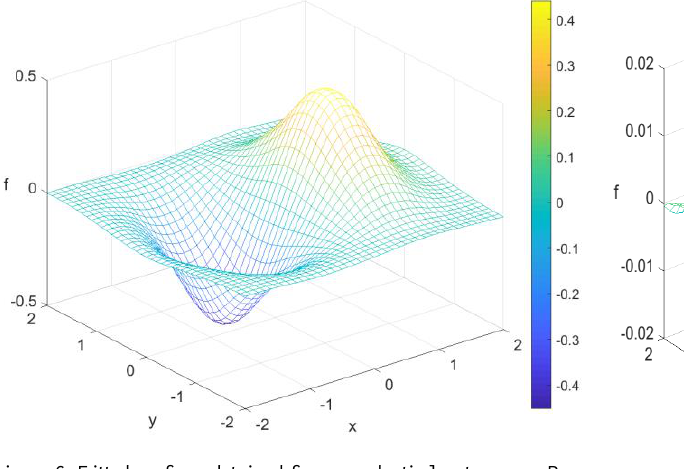
Figure 6. Fitted surface obtained from quadratic least squares B- spline Figure 8. Error in fitting cubic least squares B-spline surface